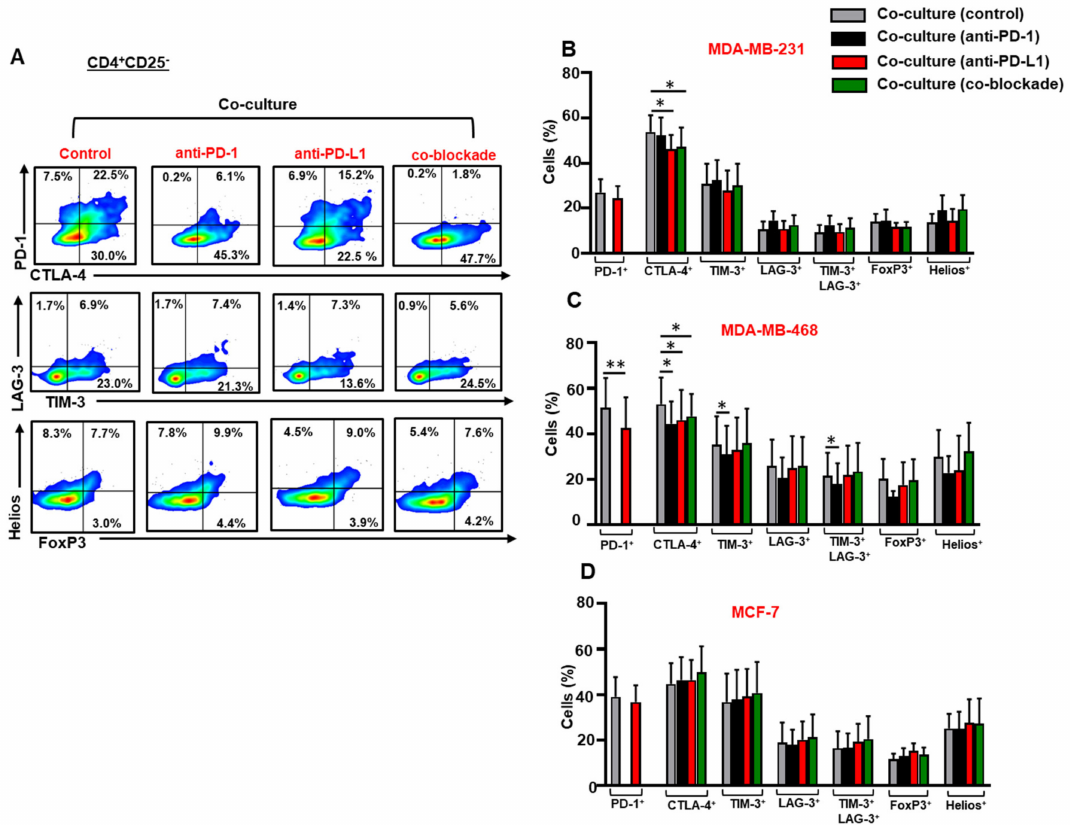
Figure 4. E ff ect of blocking PD-1 and PD-L1 on immune checkpoint and Treg-related marker expression in CD4 + CD25 − T cells. Activated PBMCs co-cultured with breast cancer cells were treated or untreated with 2 µ g / mL of anti-PD-1, 0.5 µ g / mL of anti-PD-L1 or with both mAbs. At 72 h post mAb treatment, cells were stained for immune checkpoints and FoxP3 / Helios expression, and analyzed by flow cytometry. Representative flow cytometric plots show PD-1, CTLA-4, TIM-3, LAG-3, FoxP3 and Helios expression in CD4 + CD25 − T cells from MDA-MB-231 co-culture, in the presence or absence of mAb(s) ( A ). Bar plots show the di ff erences in IC, FoxP3 and Helios expression in CD4 + CD25 − T cells in the presence or absence of MDA-MB-231 ( B ), MDA-MB-468 ( C ) and MCF-7 ( D ) cells. Data represent the mean + SEM of four independent